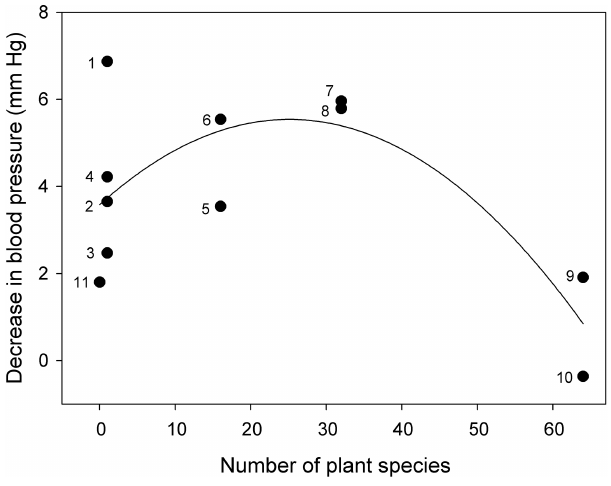
Figure 1. The effect of species richness of meadow-like arrange- ments of plants on the mean decrease in systolic blood pressure of participants during the relaxation phase after a stress treatment. During their relaxation, participants looked at arrangements of dif- ferent combinations of plant species and different species richness. Each data point depicts the mean response of participants to a cer- tain arrangement of plants. Effects are adjusted for systolic blood pressure immediately after the stress treatment. The curve shows a quadratic function fitted to the mean responses. The numbers refer to the treatment numbers in Table